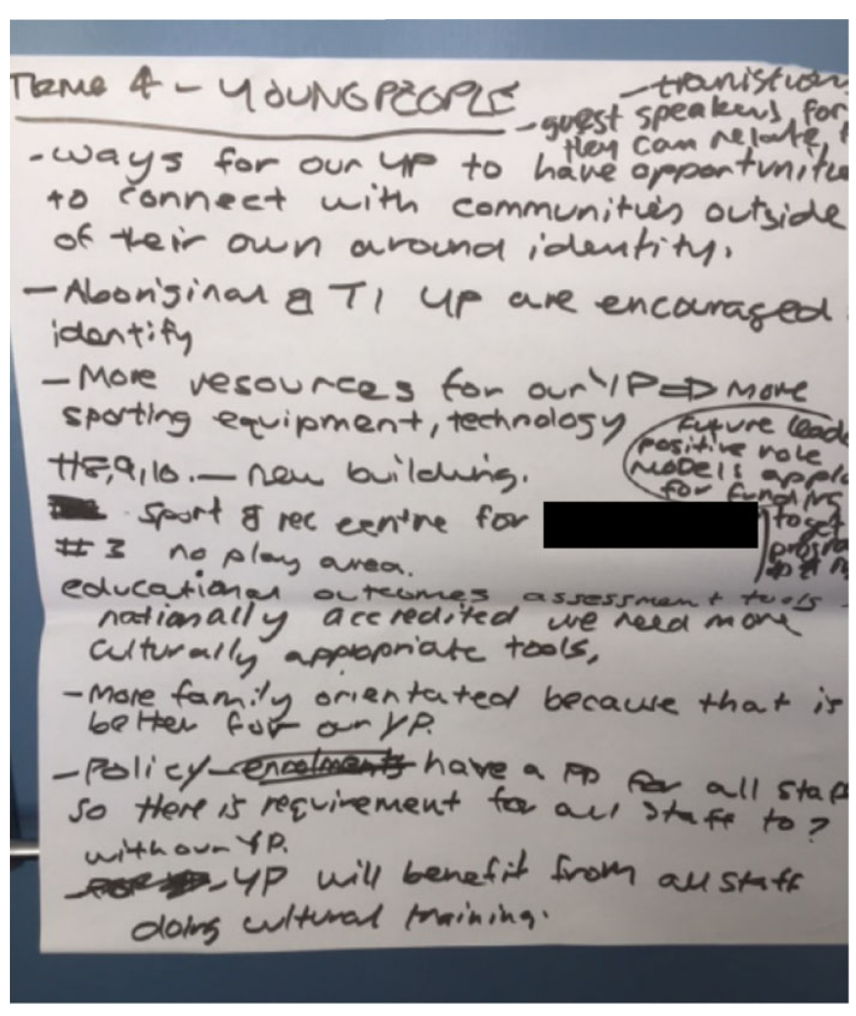
Fig. 2. Storyboard,